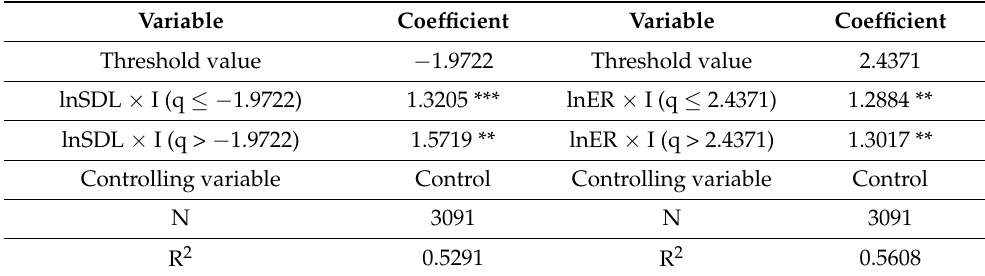
Table 5. Single-threshold regression analysis